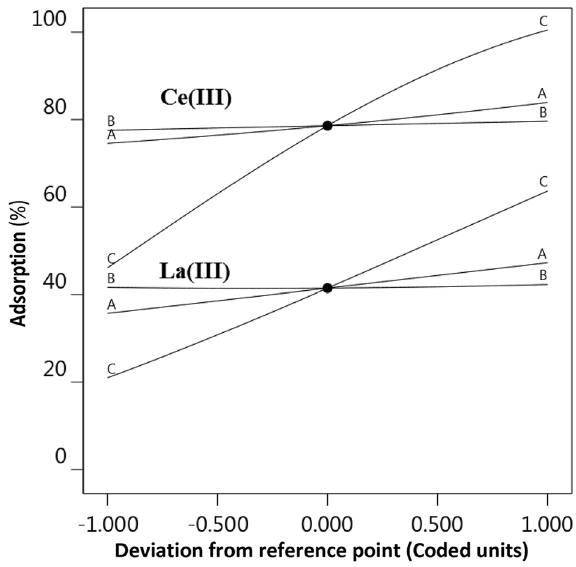
Figure 6. Perturbation plot for Ce(ΙΙΙ) and La(ΙΙΙ) ions adsorption models.